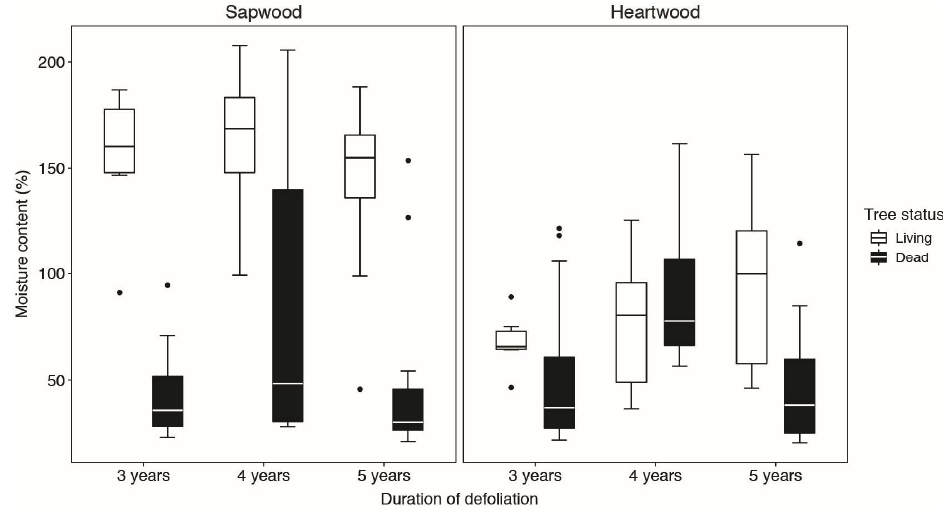
Figure 2. Moisture content in sapwood and heartwood of trees visually classified as living and dead from stands that have been defoliated for three, four or five years.